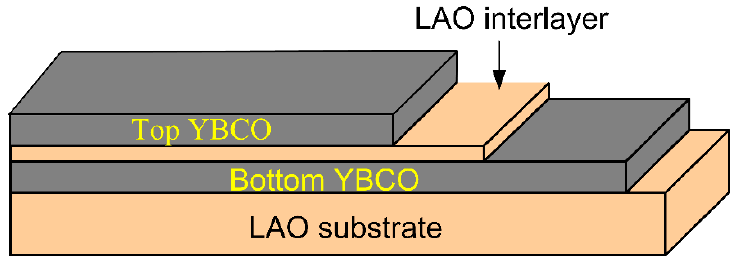
Figure 1. Schematic diagram for YBCO / LAO / YBCO trilayer structure.